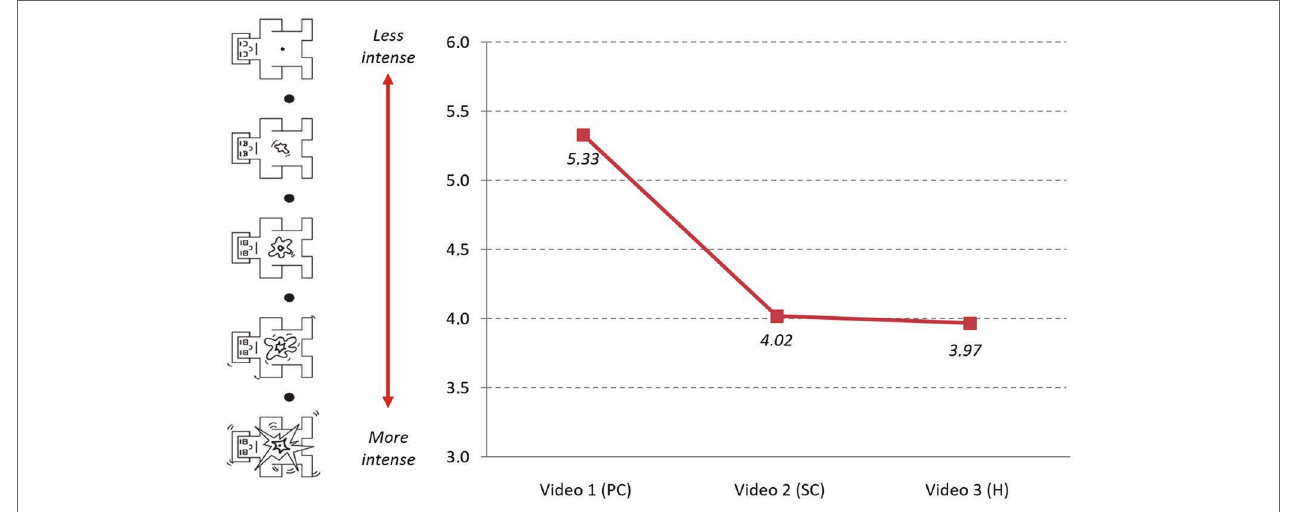
FIGURE 5 | Evolution of arousal (SAM) during the PJ.